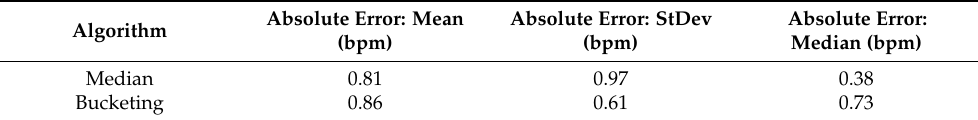
Table 8. Error statistics for hr estimation using median/bucketing algorithms.